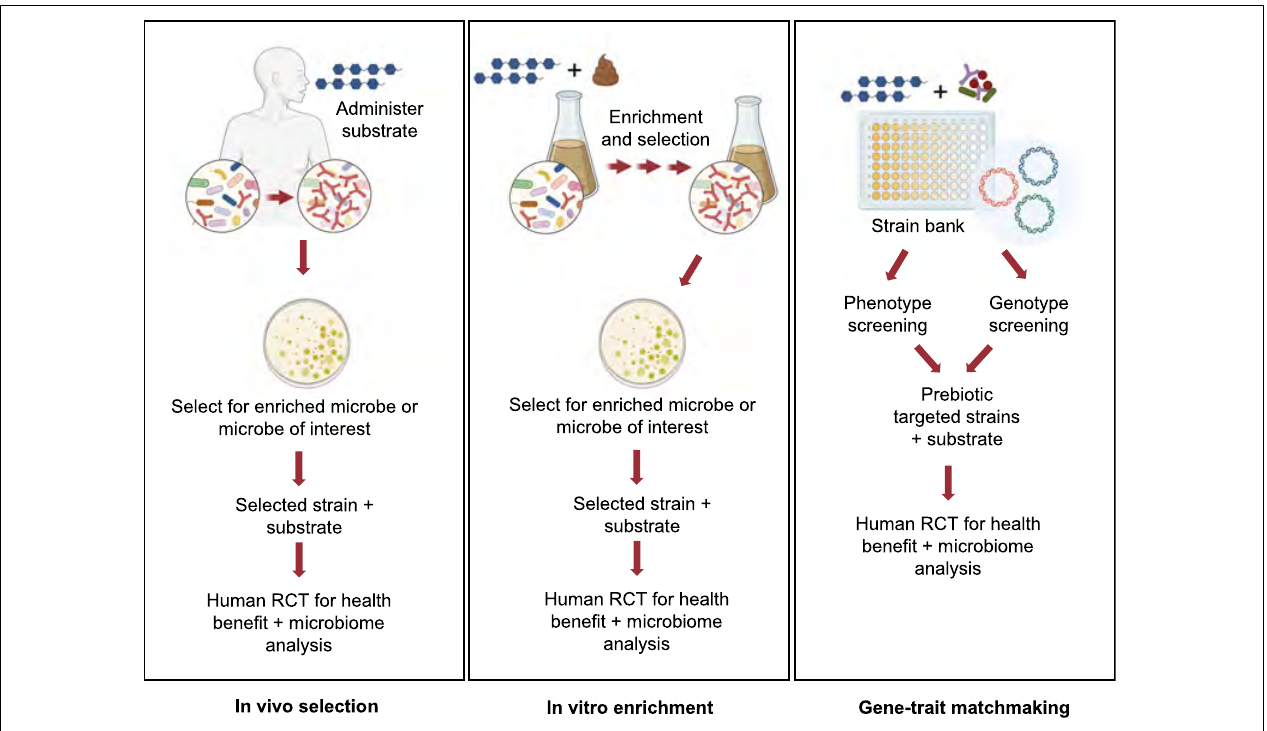
FIGURE 1 | Pre-clinical approaches for identifying potential synergistic synbiotics. Several strategies for rationale identification of probiotic strains that can act synergistically with prebiotic substrates have been described in the literature. These pre-clinical approaches can be high-throughput and cost-effective implementations prior to a clinical study using either in vivo (A) or in vitro approaches (B,C) . Images created by